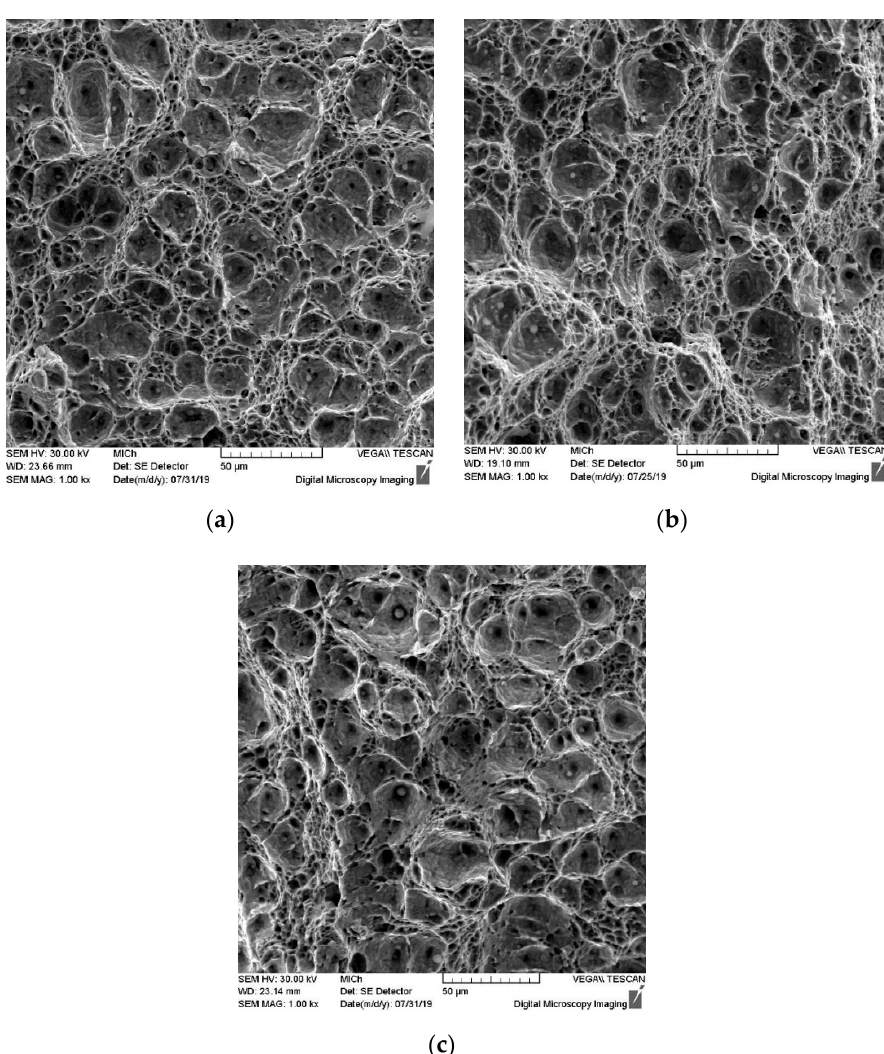
Figure 14. SEM micrographs of the fracture surface after the Charpy pendulum impact test with different cooling times: ( a ) sample 7s; ( b ) sample 10s; ( c ) sample 17s.